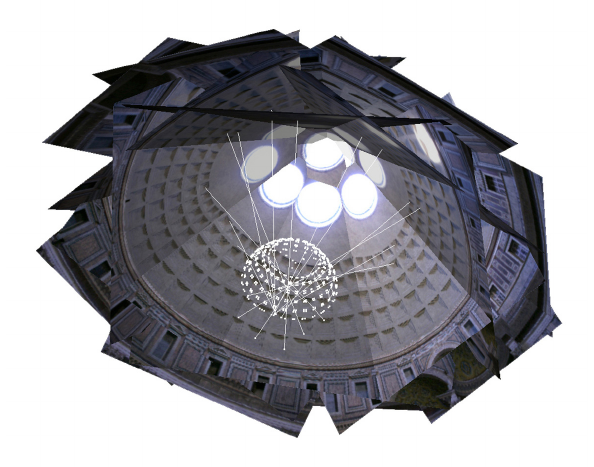
Figure 1. View of the photogrammetric model and the oriented photos used for the restitution.